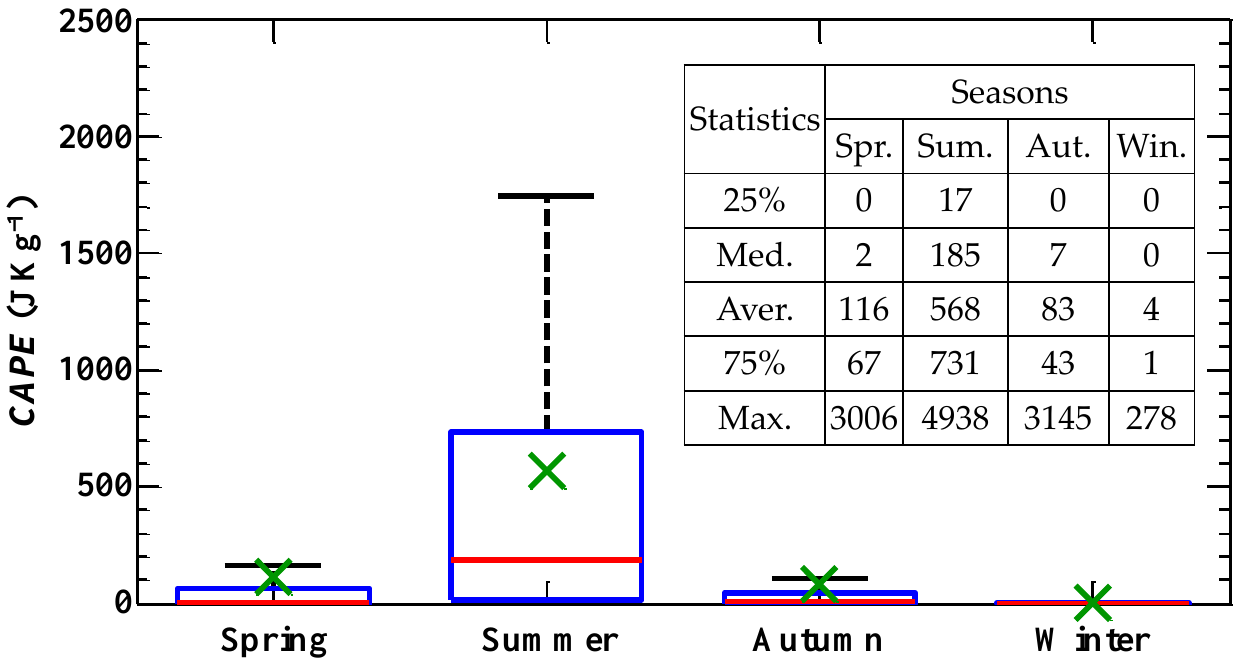
Figure 9. Seasonal averaged 850 hPa horizontal winds and relative humidity during 2018 – 2020. TP and CD denote the Tibetan Plateau and Chengdu, respectively. ( a ‒ d ) for summer, autumn, winter, and spring, respectively.